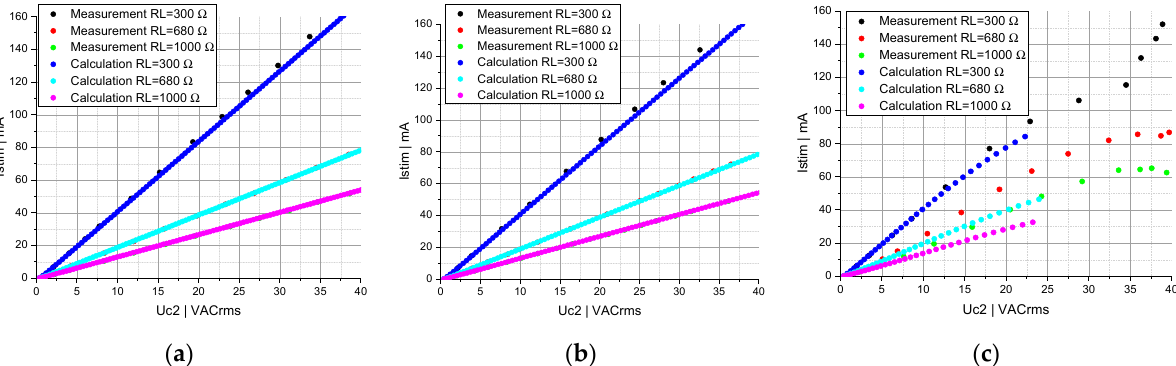
Figure 11. Stimulation current Istim as a function of the induced voltage Uc2 for a circuit topology of one linear capacitor series-connected to two parallel-connected: ( a ) linear capacitors; ( b ) linear and nonlinear capacitors; ( c ) nonlinear capacitors. The measurements (black, red, green) and calculations (blue, cyan, magenta) were performed for R L = 300 Ω , 680 Ω and 1000 Ω , respectively.